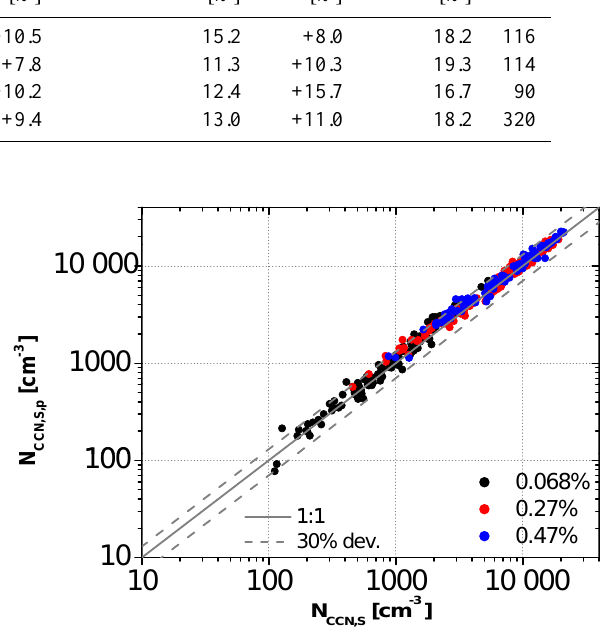
Fig. 10. Predicted CCN number concentrations ( N CCN , S , p ) based on the measured CN size distribution and κ t , p (VT,AMS) as calcu- lated from Eq. (5) plotted against the observed CCN number con- centrations ( N CCN , S ). The grey solid line is the 1:1 line, and the dashed lines indicate the band of ± 30% deviation of N CCN , S , p from N CCN , S